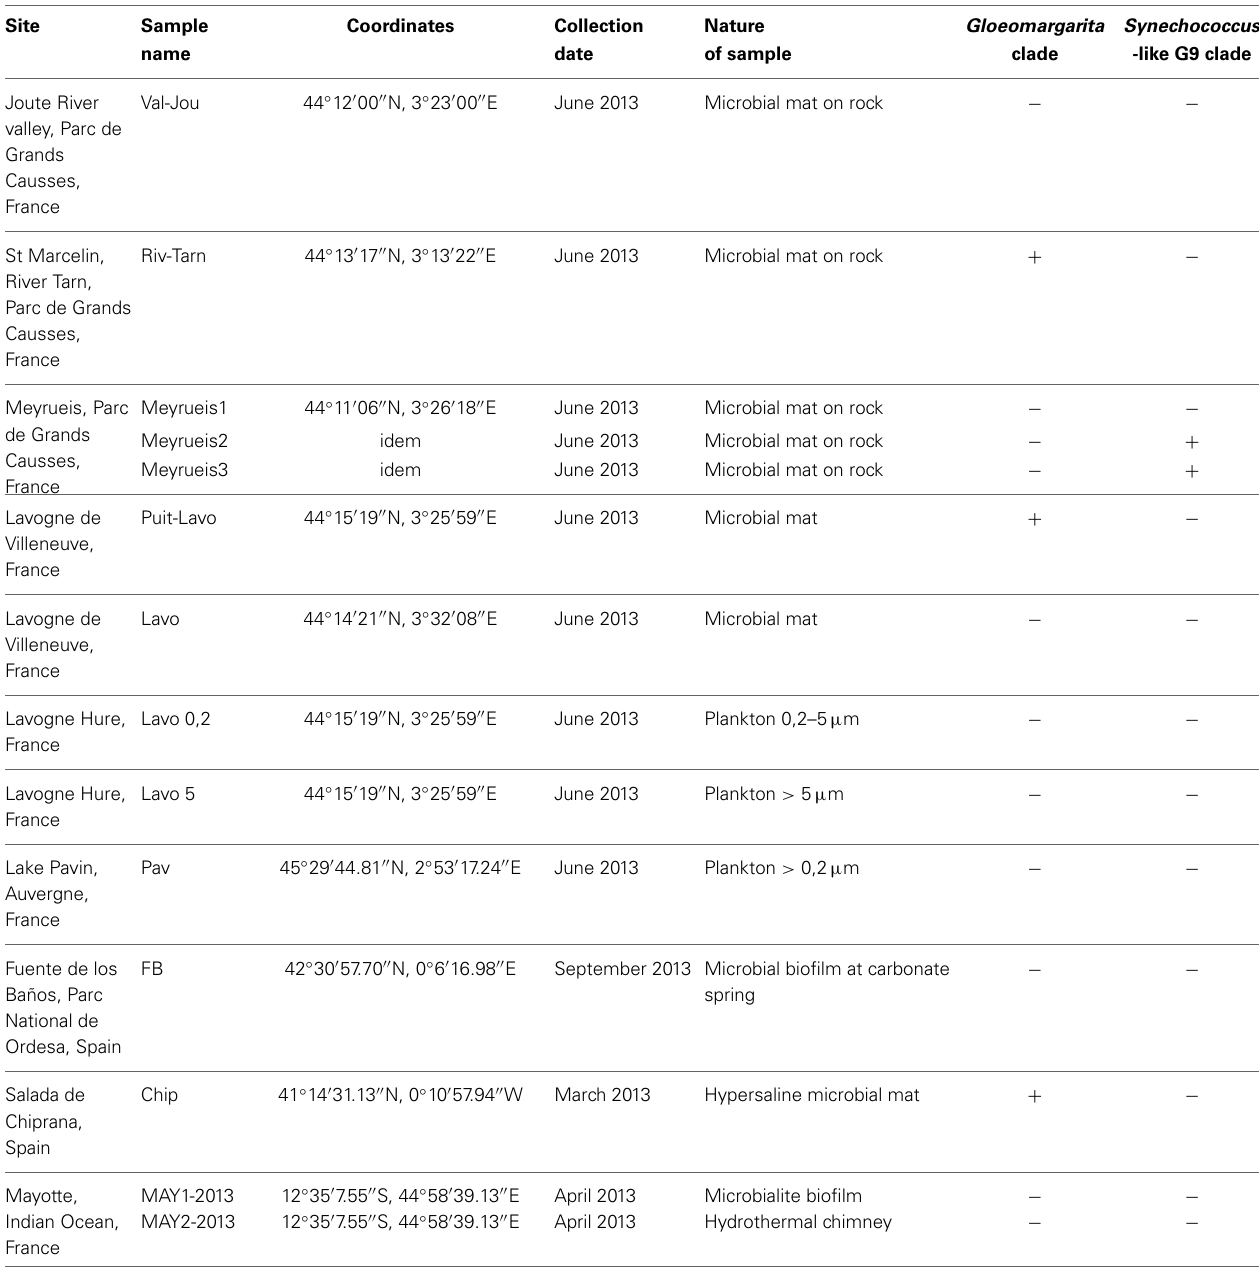
When not indicated otherwise, microbialite samples were collected near the water surface.